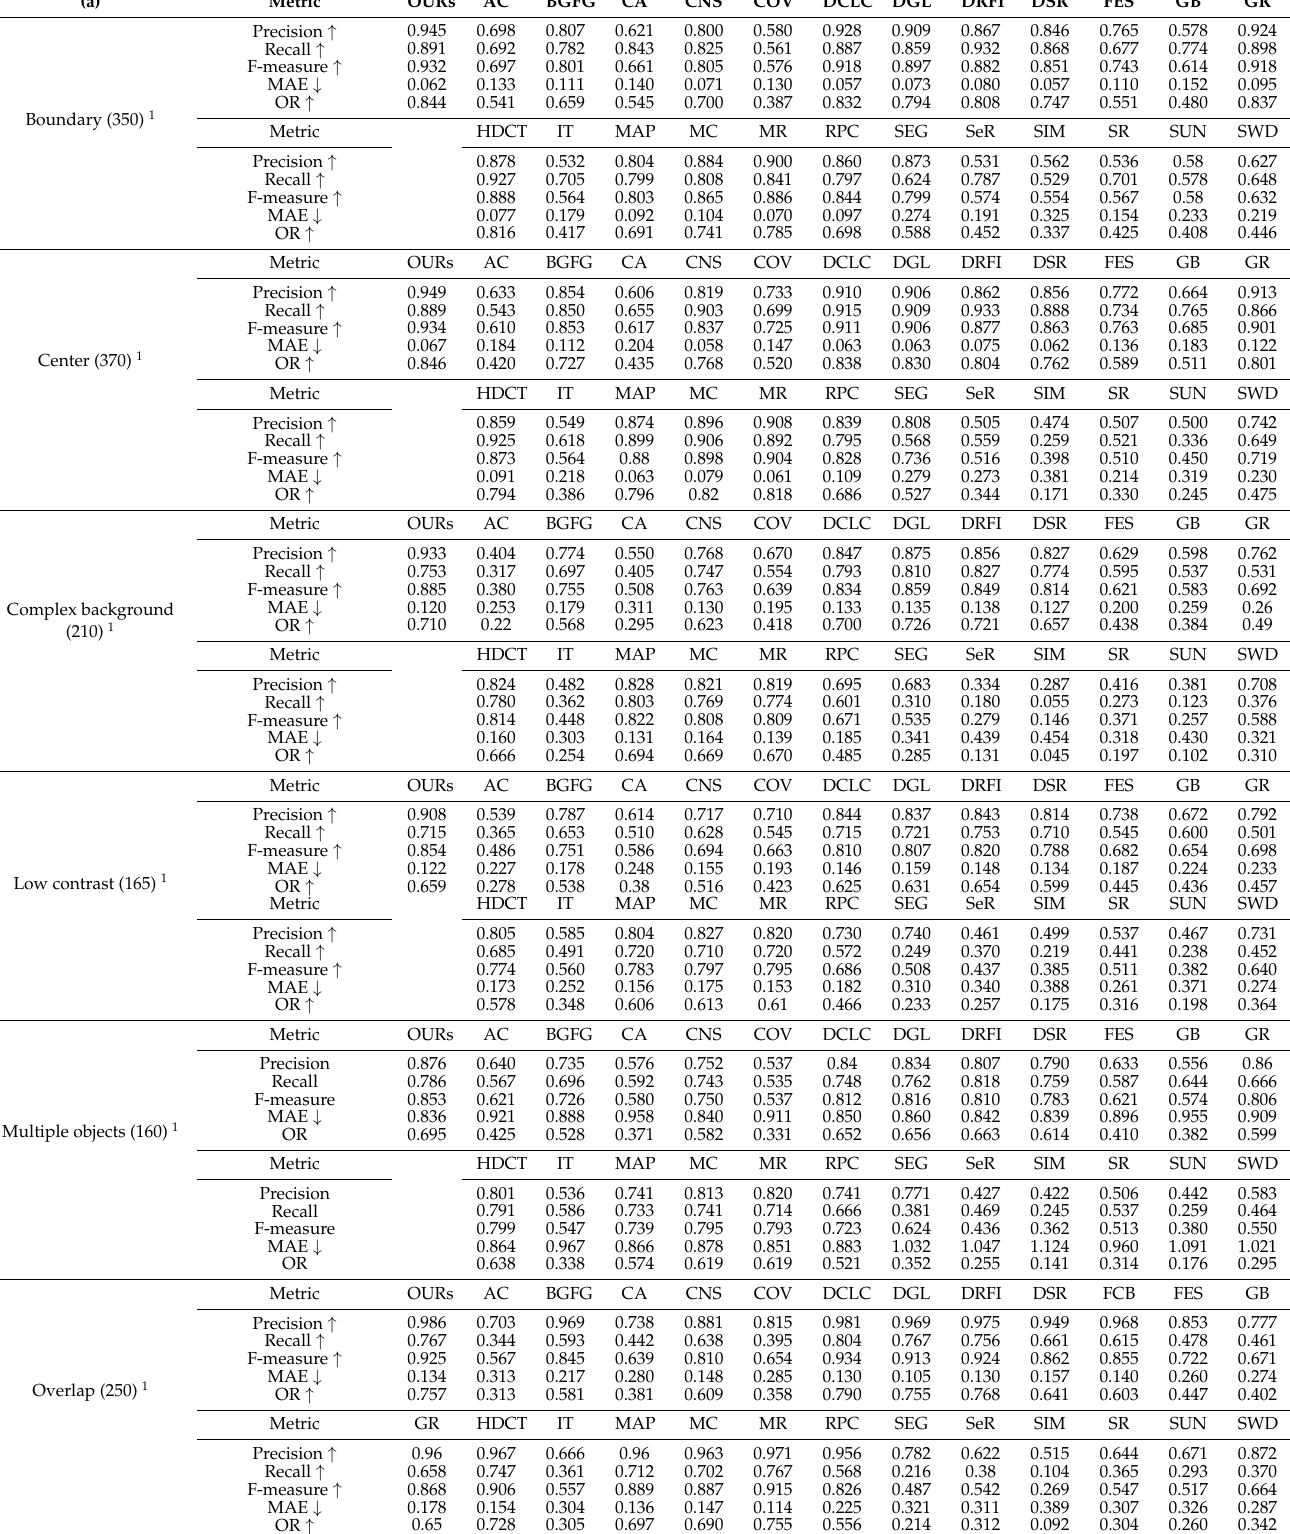
Table 2. The performance statistics for six categories of images. The up arrow ↑ indicates that a higher value gives better performance, and the down arrow ↓ shows that a lower value gives better